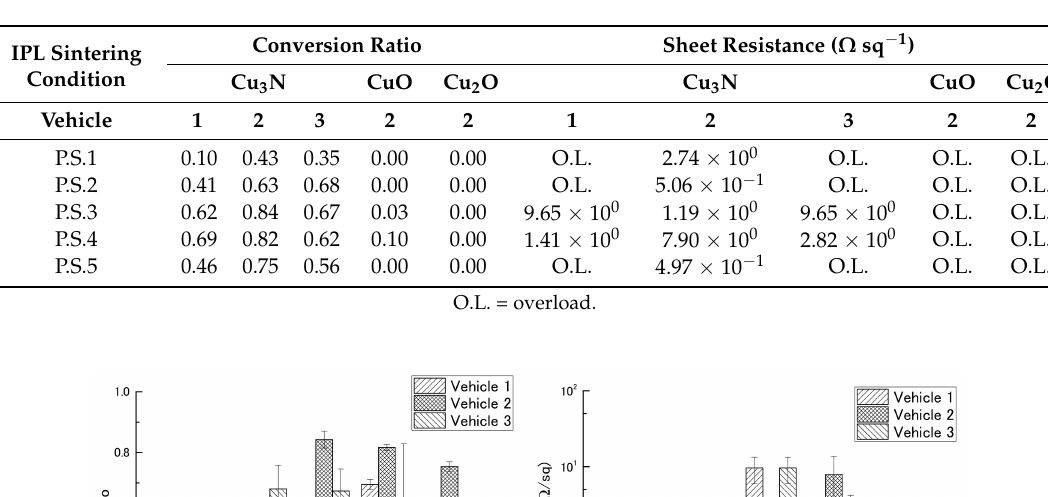
Table 5. Copper conversion ratio and sheet resistance obtained by using the intense pulsed light sintering conditions shown in Table 4.